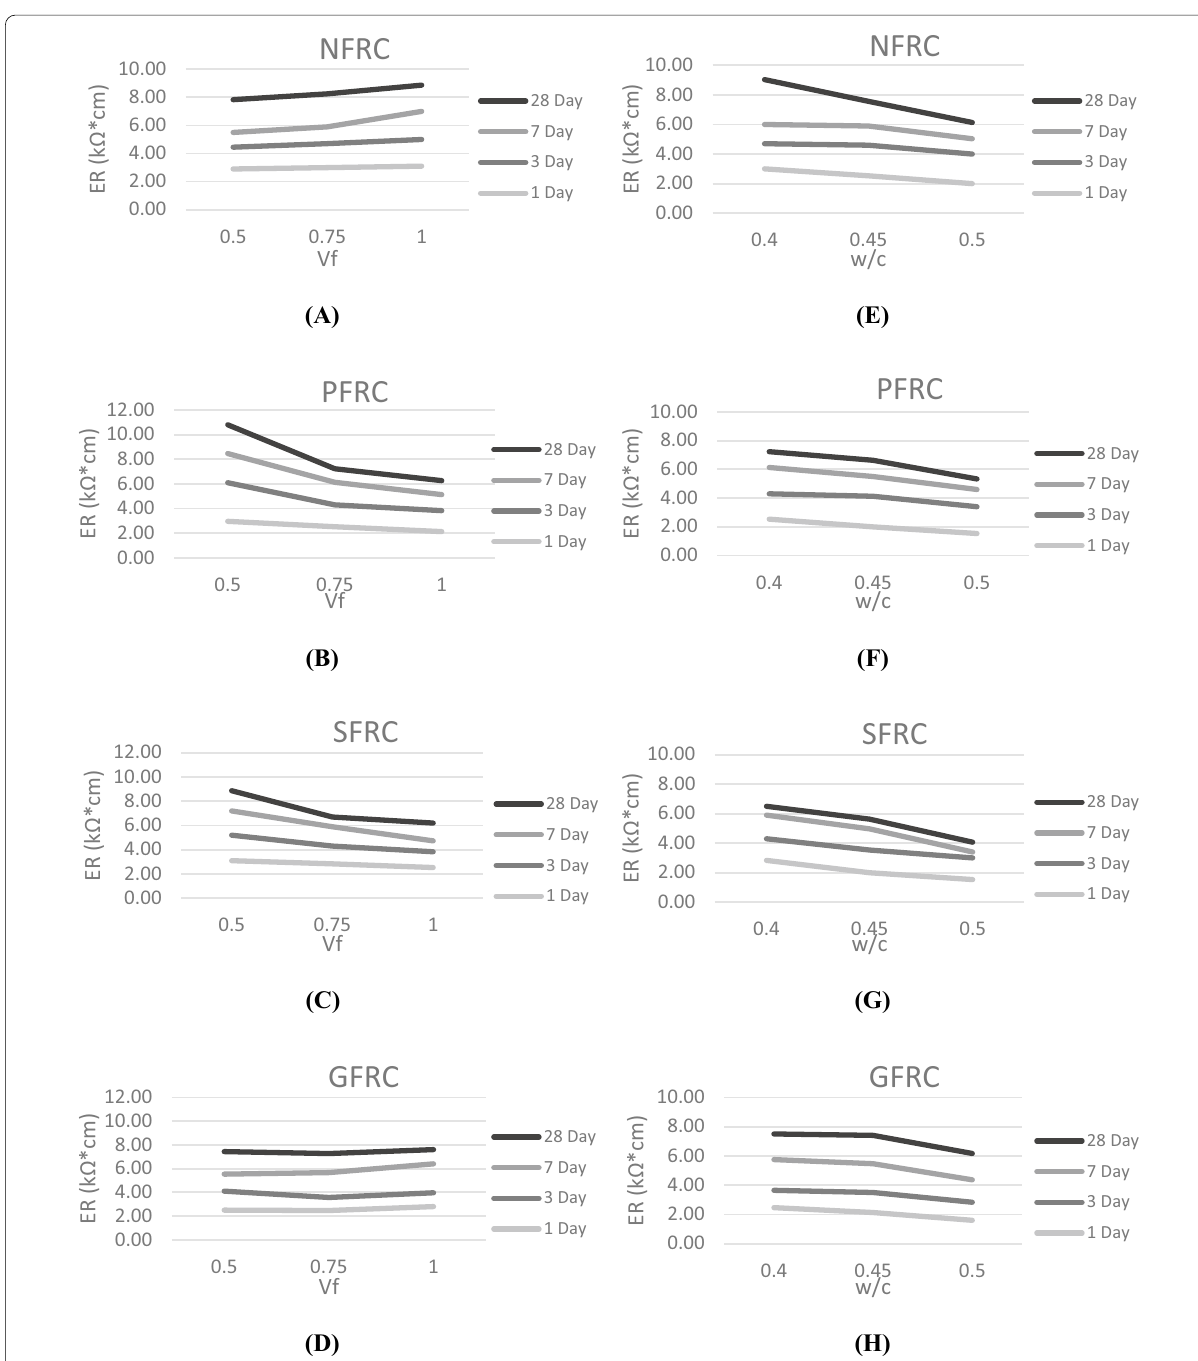
Fig. 1 A–D Effect of volume percentage ( V f ) on electrical resistivity of FRC; E–H Effect of w / c ratio on electrical resistivity of